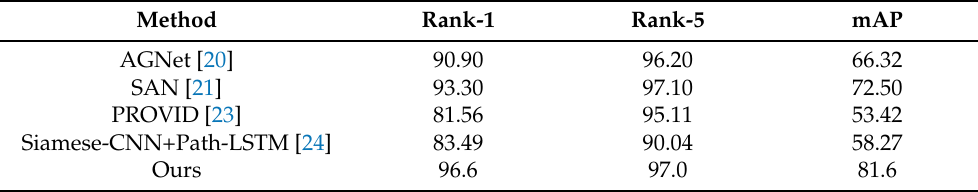
Table 3. Comparison with attribute based methods on VeRi dataset.